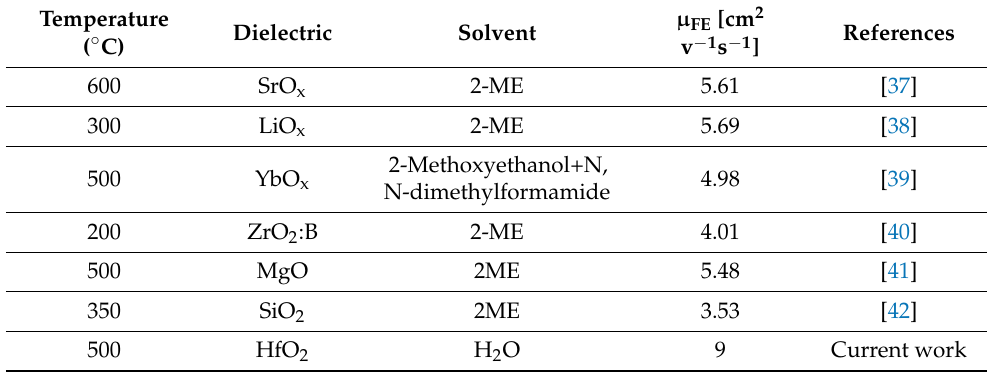
Table 2. Field effect mobility of the solution process In 2 O 3 TFTs based on various high-k